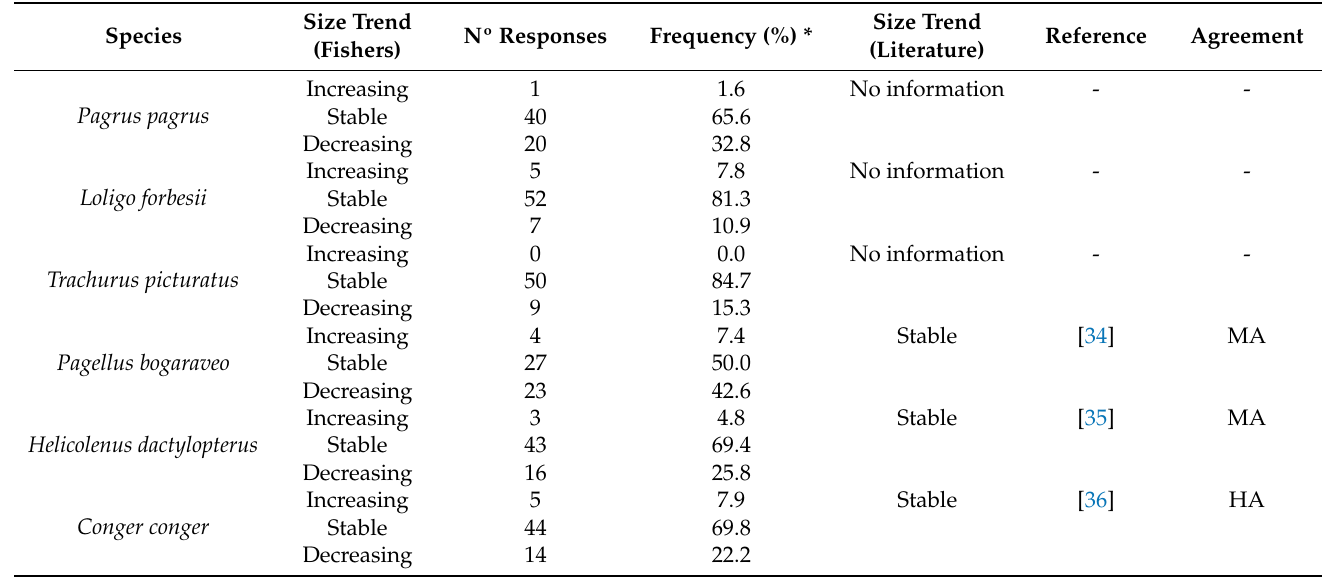
Table 3. Size trend of the six species studied in the Azores according to fishers’ experiential knowledge, obtained from scientific literature, and the agreement between these two sources of information. MA = medium agreement; HA = high agreement. Nº responses = number of fishers who answered this item.